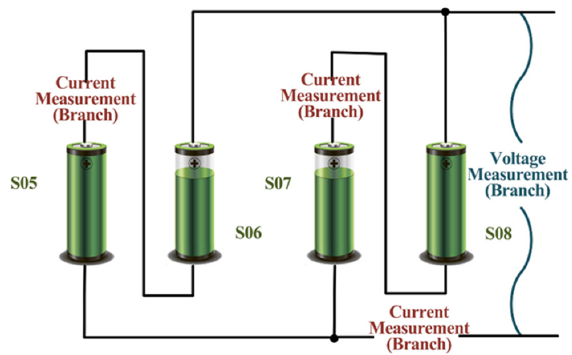
Figure 15. Series-parallel pack measurement schematic diagram.